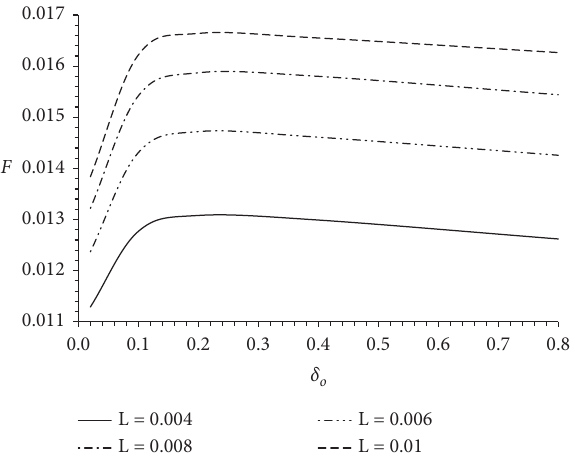
Figure 14: F vs δ � 0.5, o at different channel heights for case O for radius ratio χ 2 � 0.3, K r � 10, E � 0.5.